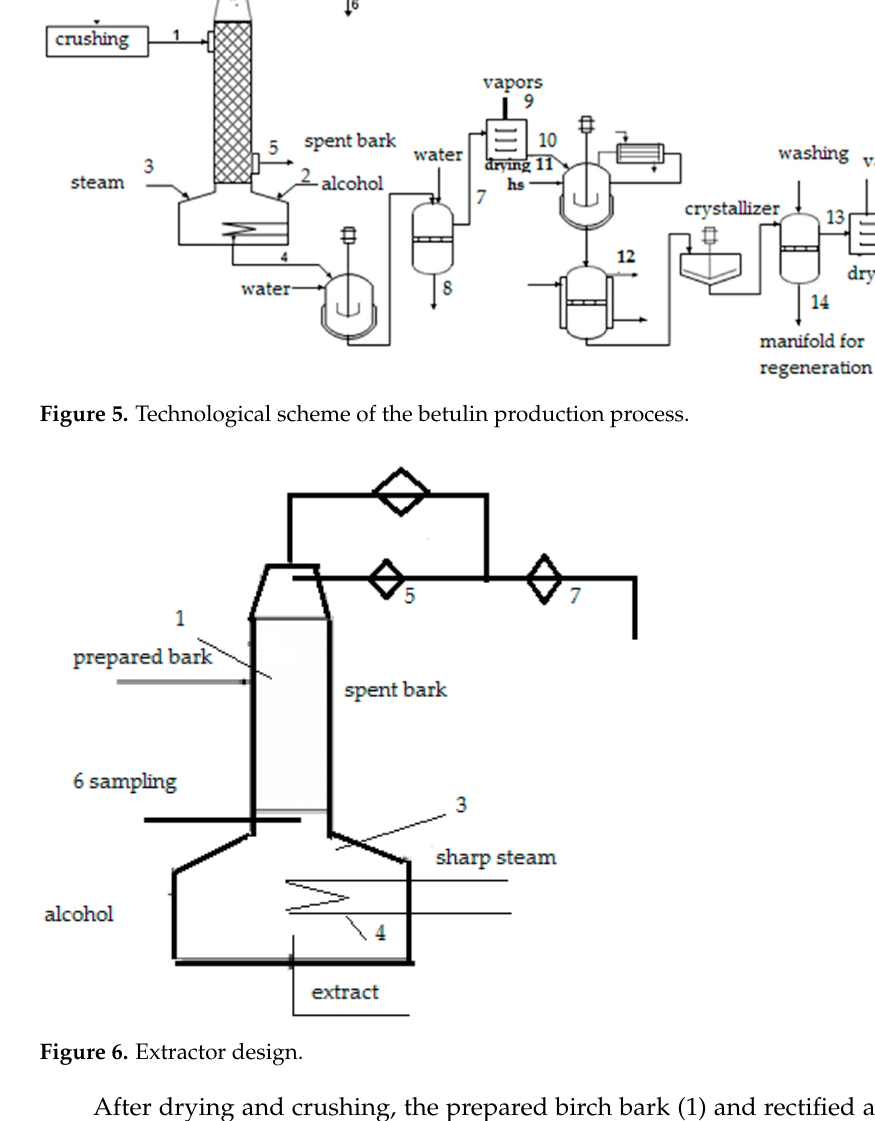
Figure 6. Extractor design.